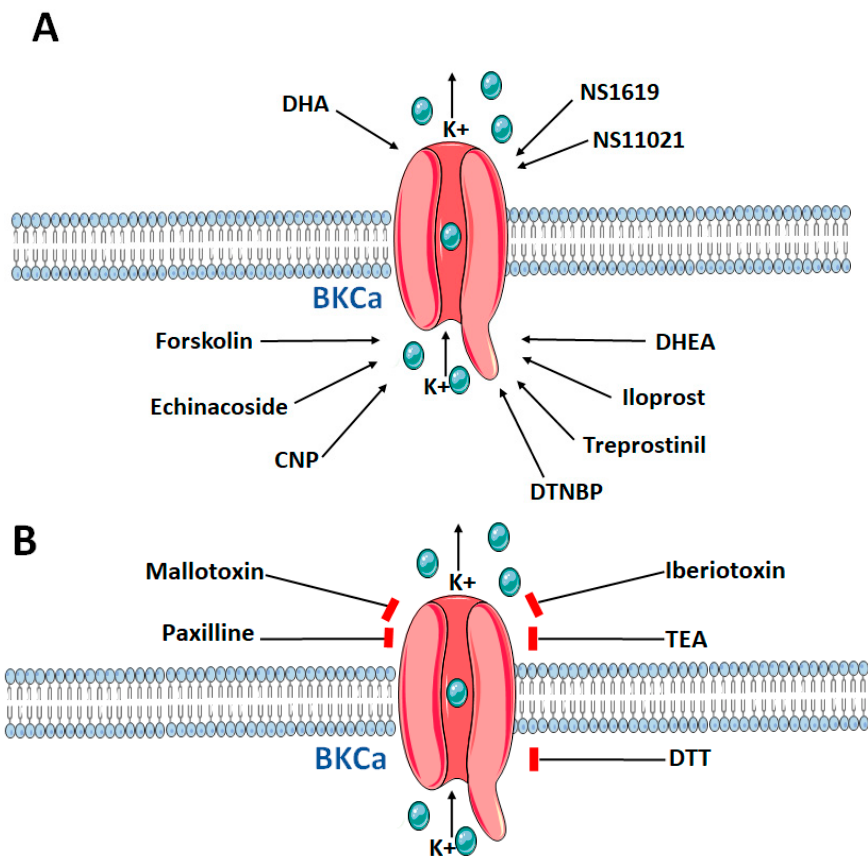
Figure 3. Exogenous activators ( A ) and inhibitors ( B ) of BKCa channels. BKCa: Big/large conduct-